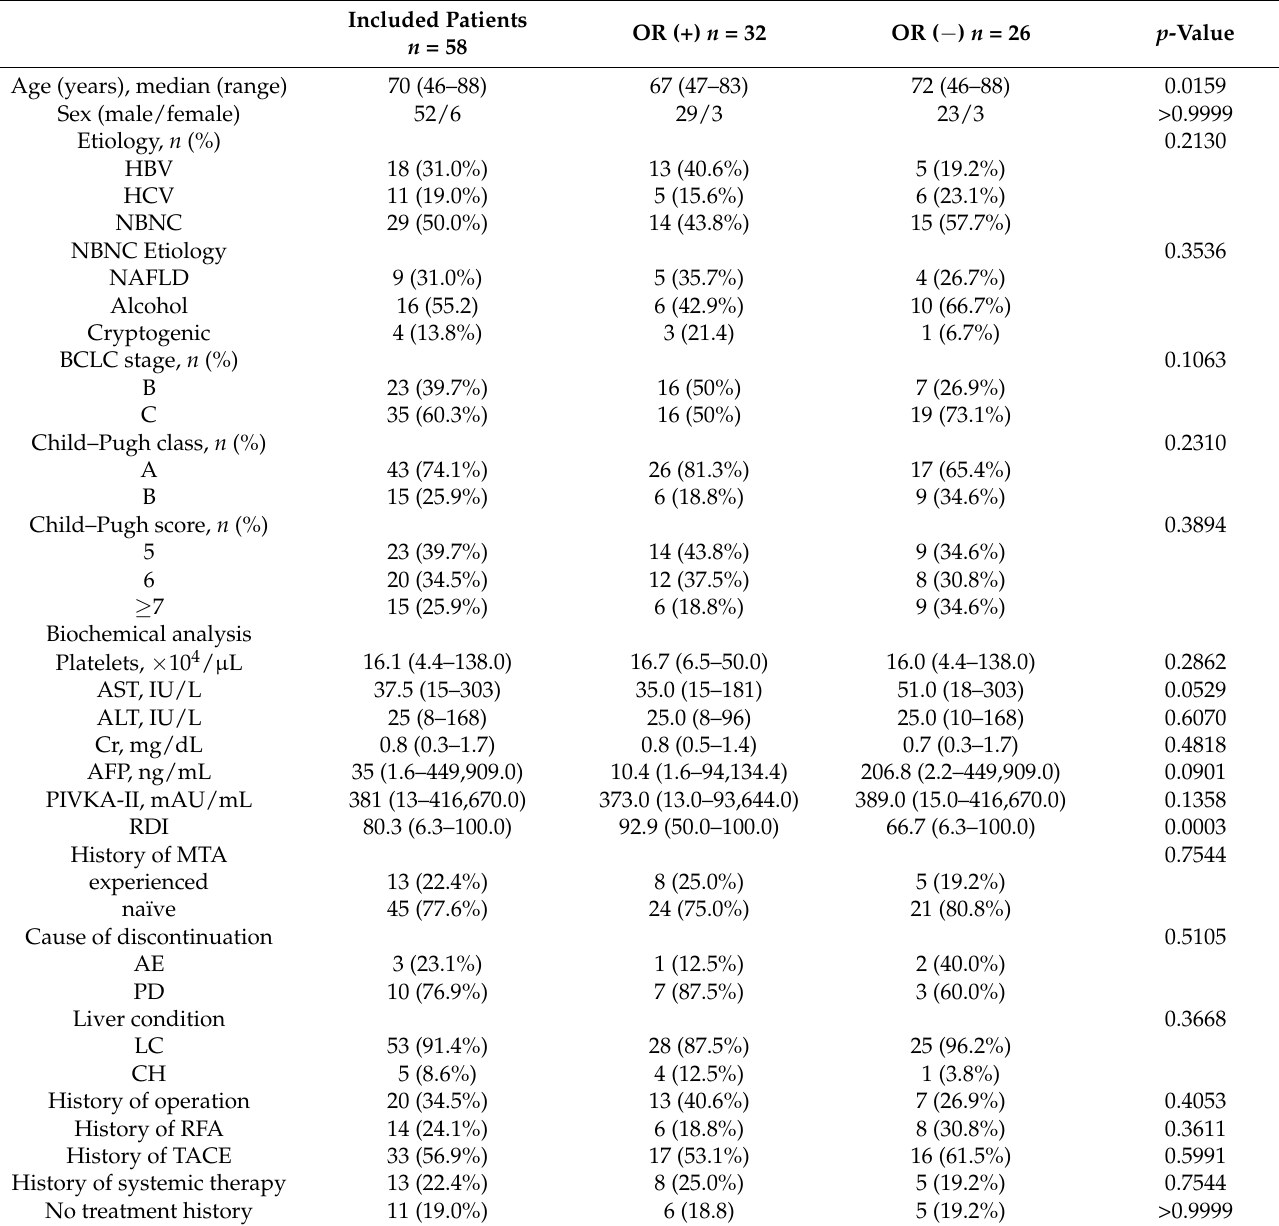
Table 1. Baseline patient